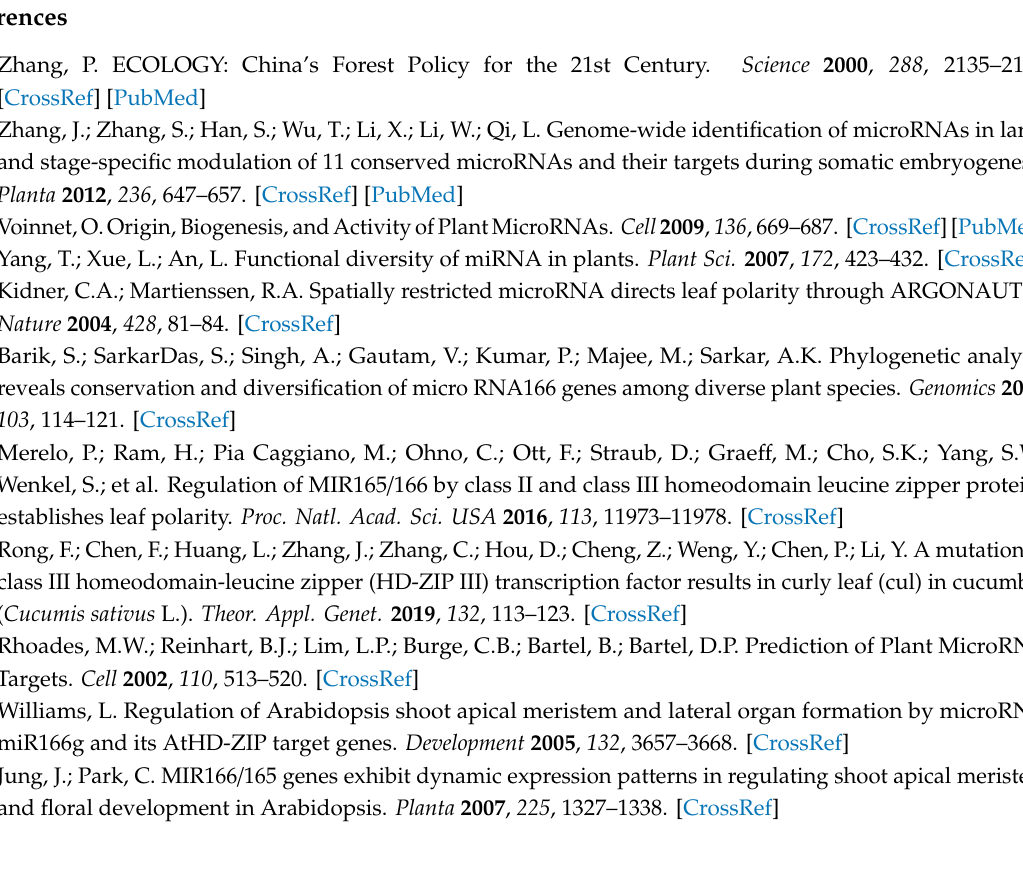
Supplementary Materials: The following are available online at http: // www.mdpi.com / 1999-4907 / 11 / 12 / 1367 / s1, Table S1: title Total identified metabolites in WT, a-3, a-4 and a-5; Table S2: title Di ff erentially accumulated metabolites (DAMs) in WT, a-3, a-4 and a-5 respectively; Table S3: title KEGG enrichment analysis of di ff erentially Table S5: title Metabolome and transcriptome association analysis of co-mapped KEGG pathways enriched in WT vs a-3, WT vs a-4 and WT vs a-5; Table S6: title Metabolome and transcriptome association analysis of flavonoid biosynthesis and phenylpropane biosynthesis enriched in WT vs a-3, WT vs a-4 and WT vs a-5. Author Contributions: Y.F. designed the experiments and drafted the manuscript; Y.F. and Z.L. carried out the experiments, data analysis, and revised the manuscript; L.Z. helped to perform the experiment; S.H. and L.Q. provided suggestions on the experimental design and analyses. All authors have read and agreed to the published version of the